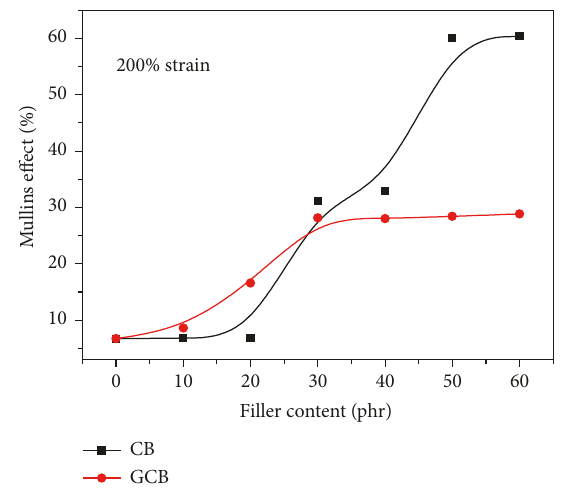
Figure 3: Apparent crosslink densities of NR/CB and NR/GCB. Figure 4: Effect of filler content on Mullins effect of NR/CB and